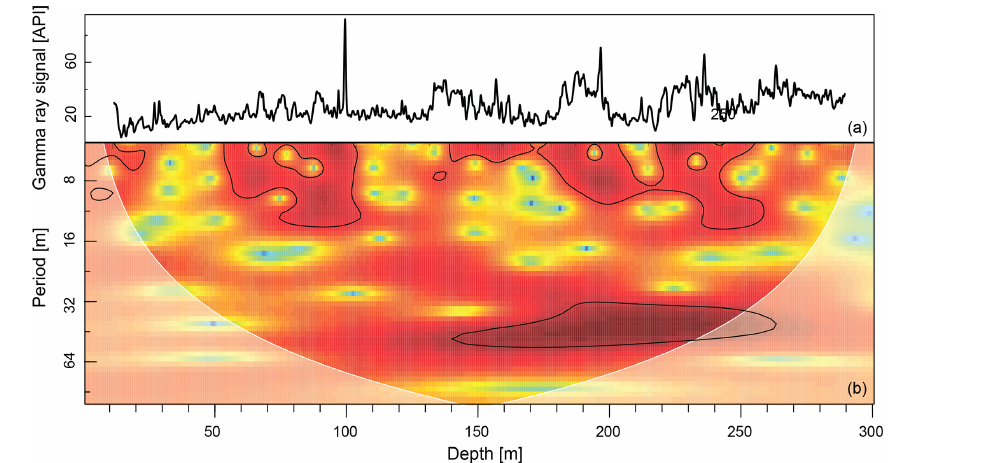
Figure 6. Wavelet analysis (Gouhier et al., 2018; b ) of (total) gamma ray data (a) from the upper 300m of Lake Chalco sediments. Red colors indicate strong cyclic behavior and black markings indicate the results of a significance test. White coloring indicates the cone of influence.